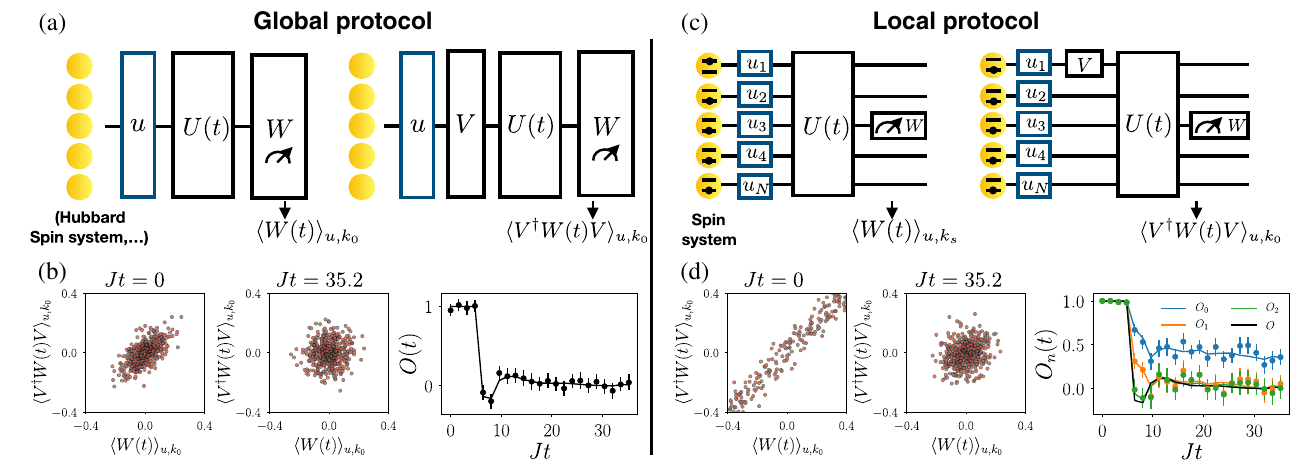
FIG. 1. Probing scrambling via statistical correlations in a spin system. (a) The global protocol consists in separately measuring and h V † W ð t Þ V i u;k to obtain the OTOC O ð t Þ . (b) Numerical simulations of the protocol for the kicked Ising model with h W ð t Þi u;k 0 0 parameters h x ¼ J , h z ¼ 0 . 809 J , JT ¼ 1 . 6 , N ¼ 8 , and j ¼ 3 . The first two panels show the statistics of the measurement at Jt ¼ 0 and Jt ¼ 35 . 2 . In the third panel, the exact OTOC O ð t Þ is shown as a solid line, and the points represent the statistical correlations obtained from N u ¼ 500 unitaries and N M ¼ 500 projective measurements (per unitary), with error bars placed at (cid:2) 2 σ calculated from the jackknife resampling method. (c) Local protocol using local random unitaries. (d) Same as (b) with the local protocol, extracting the modified OTOC O n ð t Þ (calculated exactly, colored lines) from the statistical correlations (circles with error bars). Convergence to the OTOC O ð t Þ (black line) is achieved for low index n ∼ 2 . Throughout this work, we use unbiased estimators for the normalization terms D ð G ; L Þ